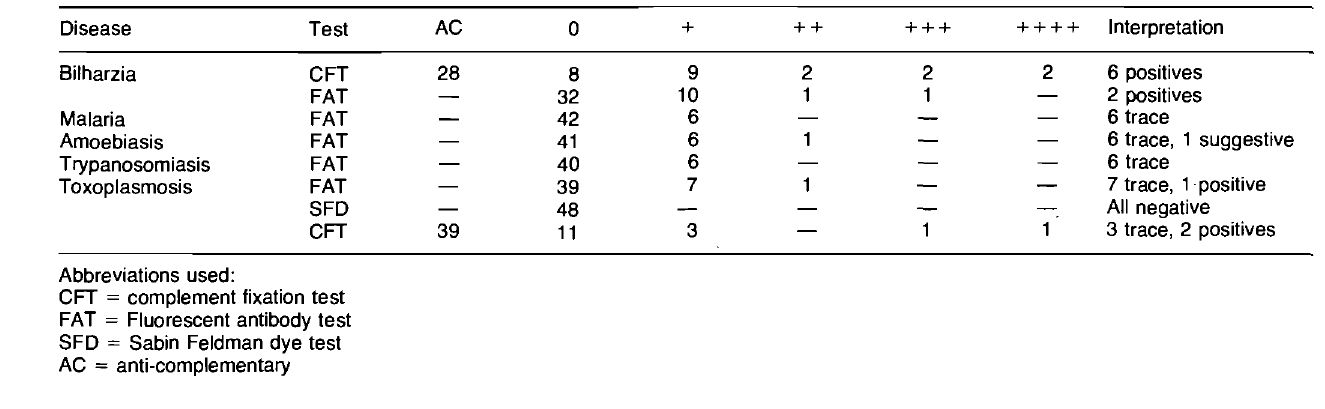
Table 4: ANTIBODY LEVELS AGAINST PARASITIC INFECTIONS